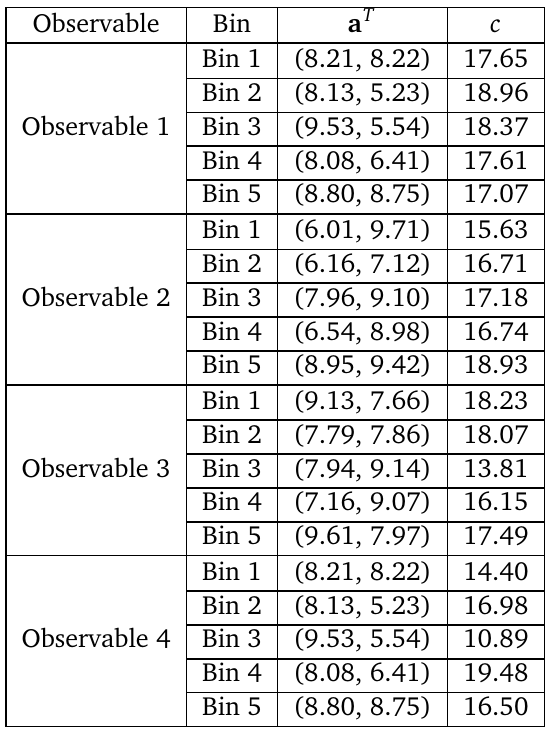
Table 32: Coefficients of the approximation f function of the form a T p + c of the toy model from the closure test described in Section 4.8.